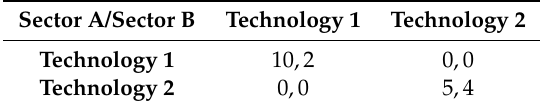
Table 2. Payoff matrix for a coordination game between two agents where neither of the two pure Nash Pareto dominates the other. States where both agents play the first strategy (Technology 1) are nearly socially optimal and they can be selected via a bifurcation